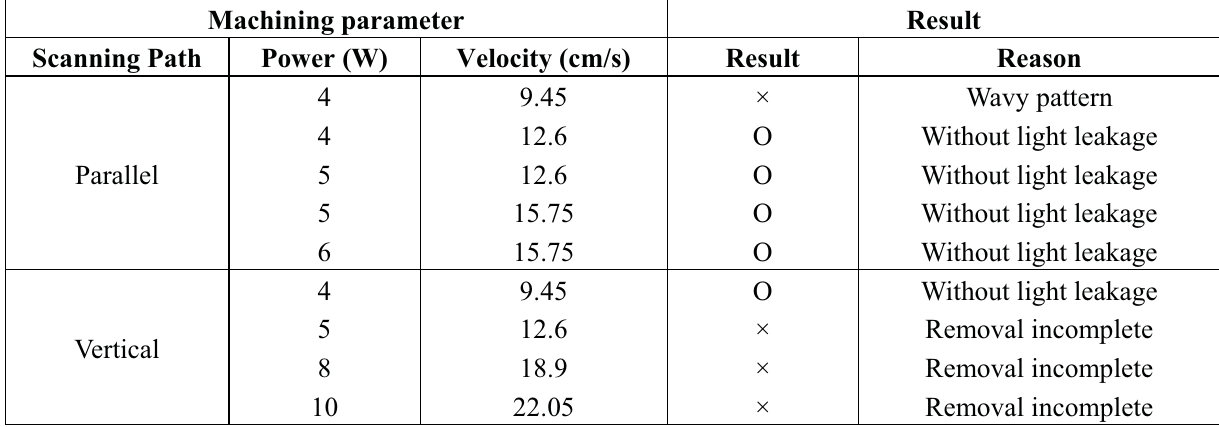
Table 3. Results of the qualitative analysis of optical transmission